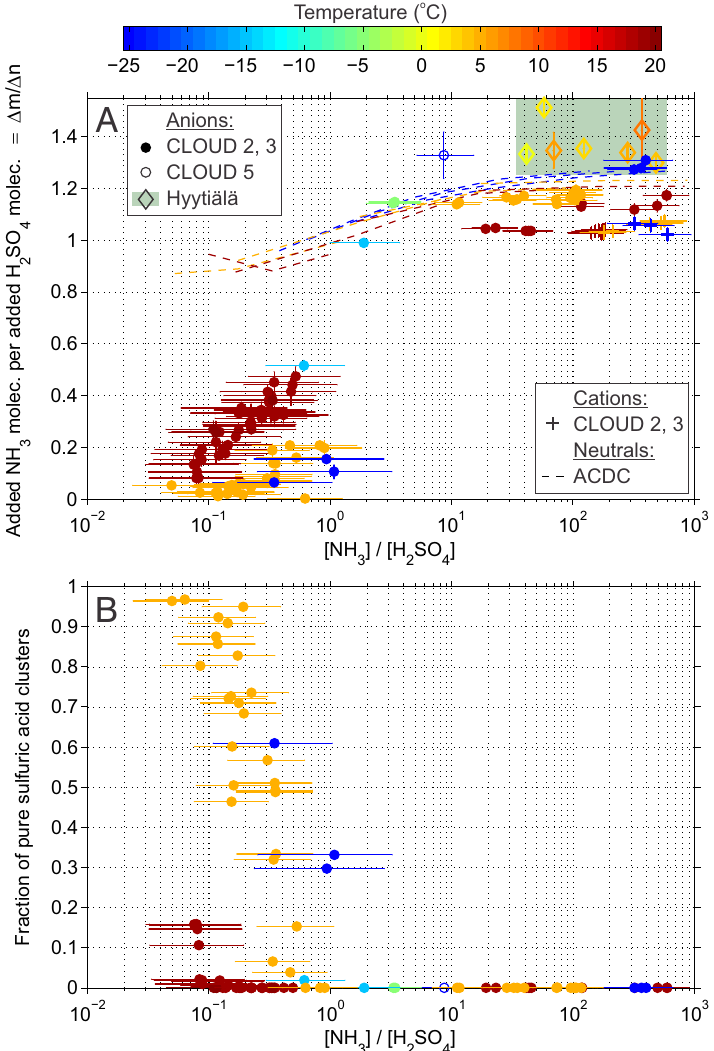
Figure 6. The composition of anion clusters, (NH 3 ) m · (H 2 SO 4 ) n · HSO − , during new-particle formation experiments in the CLOUD cham- 4 ber, shown as circles. RH was in the range 37–41%; temperature is given by the color scale. (a) Number of gained NH 3 molecules per gained H 2 SO 4 molecule, (cid:49)m / (cid:49)n , plotted against the ratio of NH 3 and H 2 SO 4 gas-phase concentrations, [NH 3 ]/[H 2 SO 4 ]. (cid:49)m / (cid:49)n for anion clusters was calculated for the range 4 ≤ n ≤ 18 ∗ for the results from the CLOUD 2 and 3 campaigns, and for the range 4 ≤ n ≤ 9 for the single result from CLOUD 5. Also shown are (cid:49)m / (cid:49)n for cation clusters (NH 3 ) m · (H 2 SO 4 ) n · NH + (for the range 1 ≤ n ≤ 16 ∗ ) , which 4 are observed only at sufficiently high [NH 3 ]/[H 2 SO 4 ]. The green box and diamond markers show the corresponding results from ambient observations in the boreal forest. These are for (NH 3 ) m · (H 2 SO 4 ) n · HSO − , 4 ≤ n ≤ 8 ∗ , observed during new-particle formation in Hyytiälä 4 in spring 2011. RH varied from 36% to 61%, temperature from − 0.5 to + 8.5 ◦ C. Dashed lines are ACDC model calculations of (cid:49)m / (cid:49)n for neutral clusters (NH 3 ) m · (H 2 SO 4 ) n in the range 1 ≤ n ≤ 5. (b) Fraction of pure, NH 3 -free sulfuric acid anion clusters, (H 2 SO 4 ) n · HSO − , 4 calculated for the same ranges of n as in (a) , and again plotted against [NH 3 ]/[H 2 SO 4 ]. The legends in (a) apply to (b) as well. ∗ Actual upper limits varied depending on obtained signals. For anion clusters in the CLOUD 2 and 3 campaigns, median ( n max )=16.5; for cation clusters, median ( n max )=16; for anion clusters in Hyytiälä, median ( n max